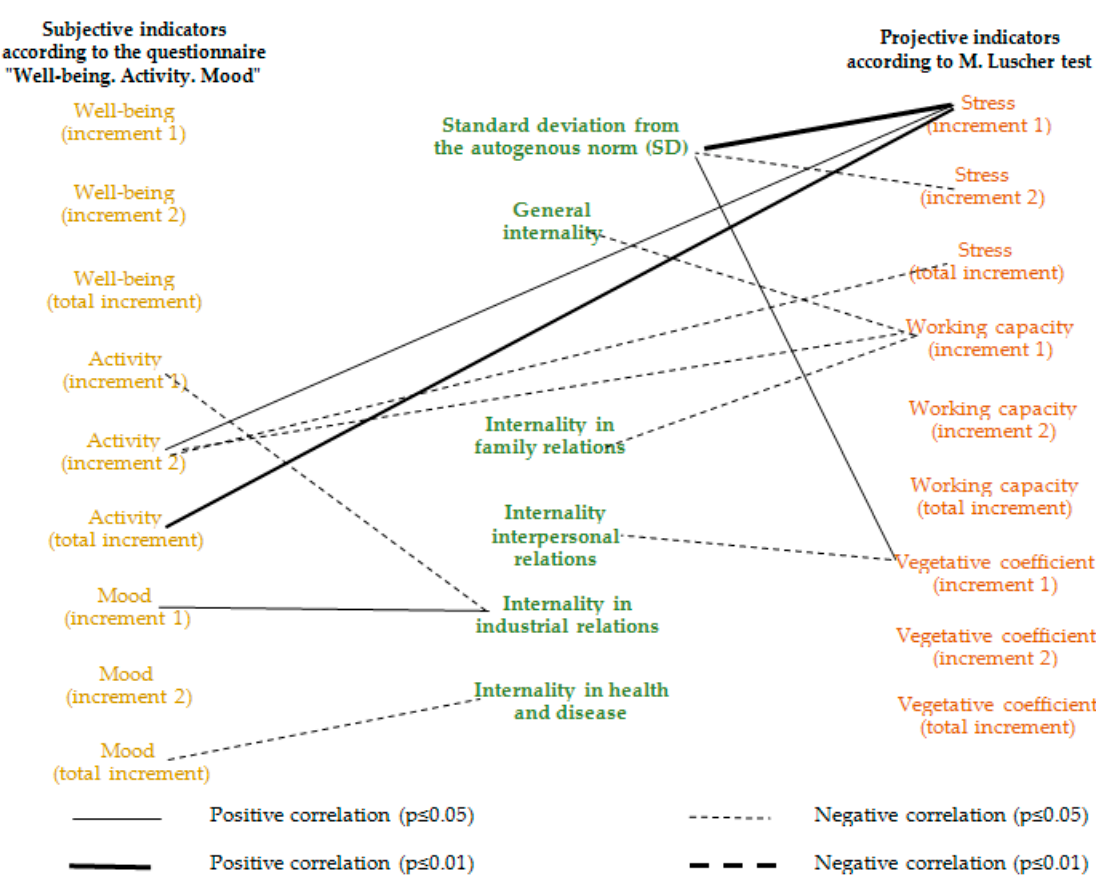
Figure 5. Correlation pleiad of relationship between subjective and projective indicators of FIFO workers’ stress and working capacity at an oil and gas production enterprise.